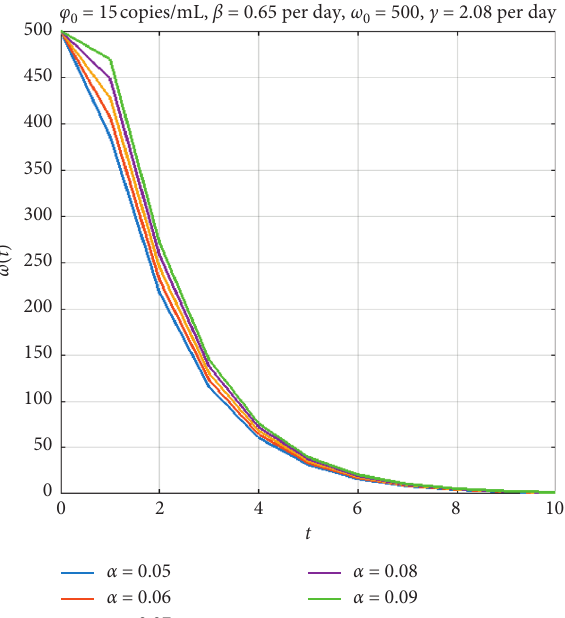
Figure 6: The number of infected cells ω for different values of time t and rate of infection α with � 15copies/mL , β � 0 . 65 day − 1 , ω � 500 , and c � 2 . 08 day − 1 . φ 0 0